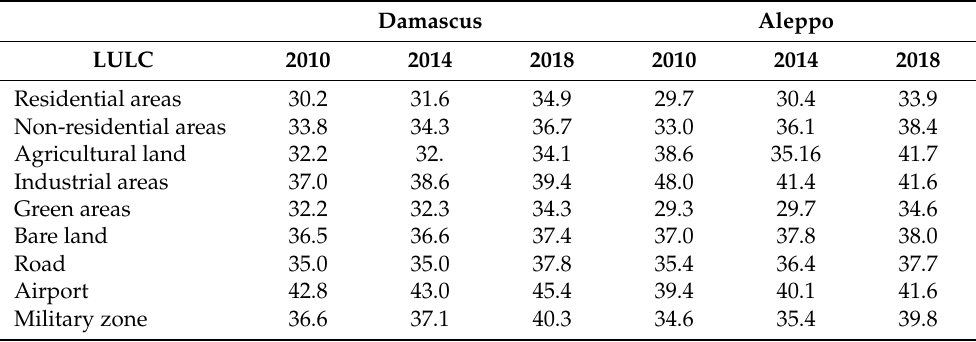
Table 8. LST values (mean in ◦ C) for each LULC type in Damascus and Aleppo between 2010 and